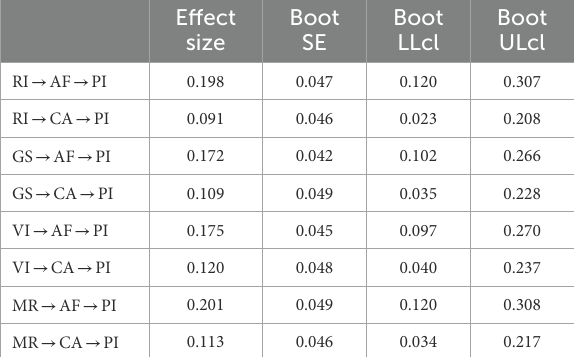
TABLE 9 Mediating effect test results.